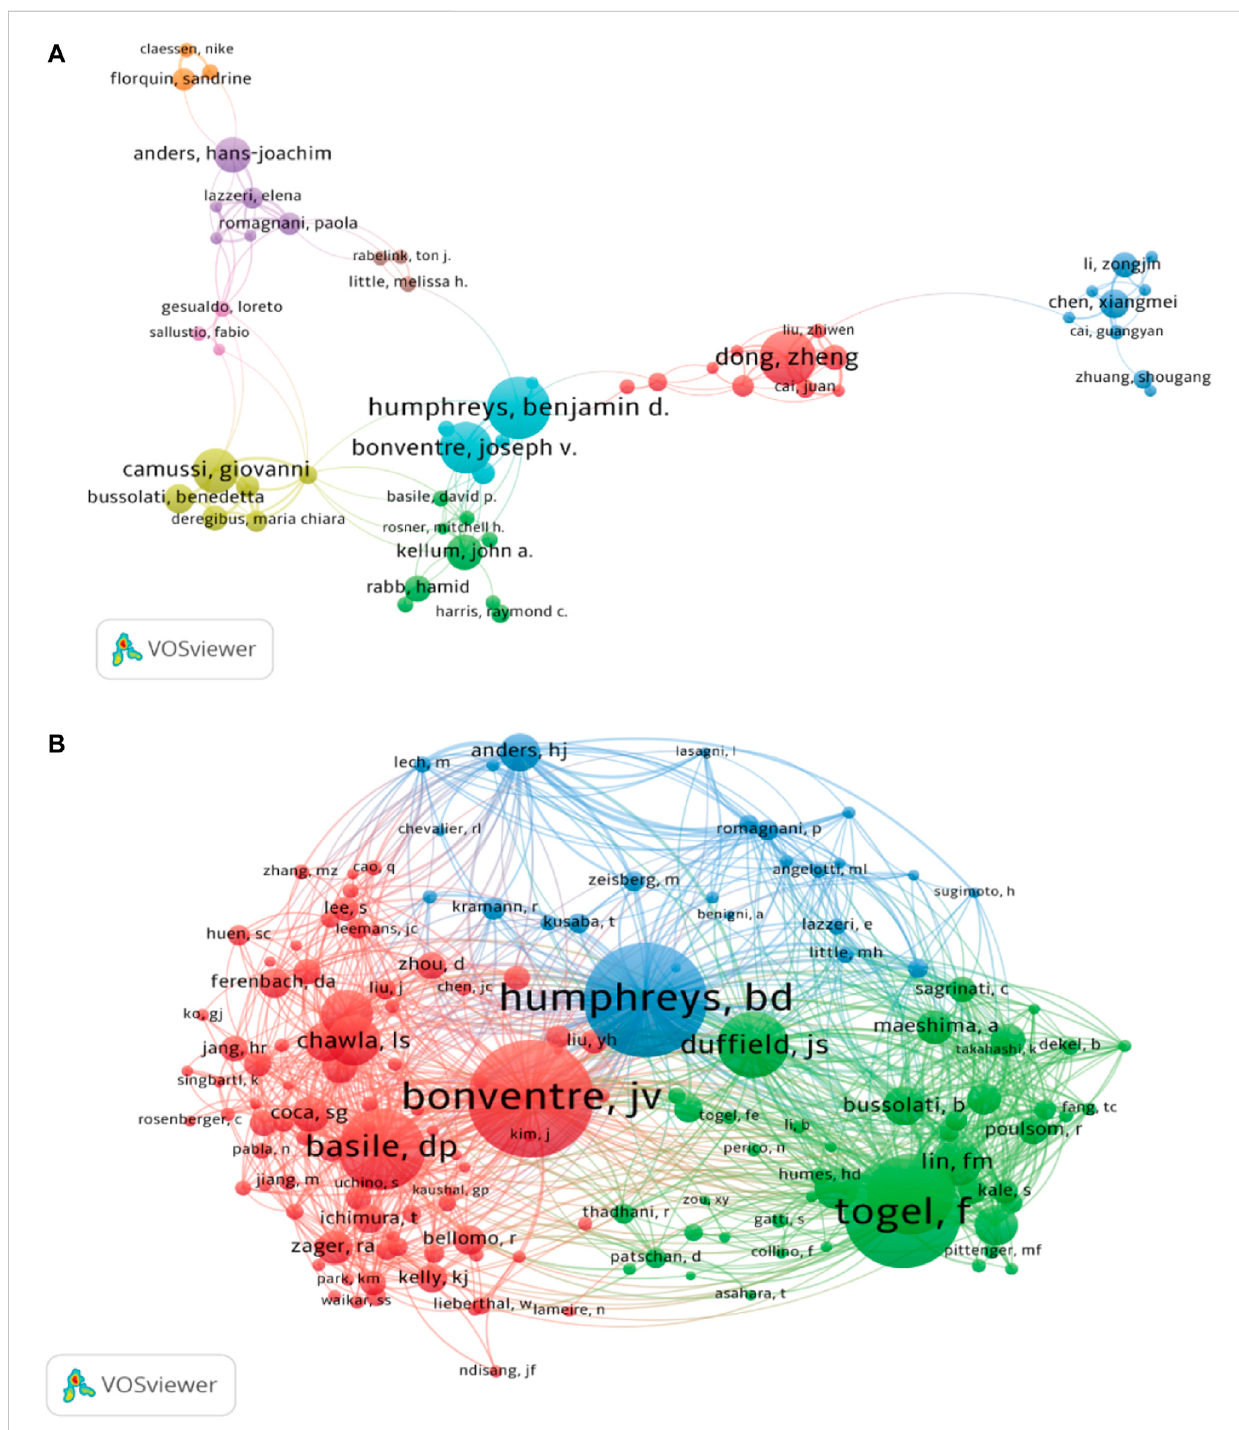
FIGURE 4 The author cooperation map (A) and author co-citation map (B) generated by VOSviewer.